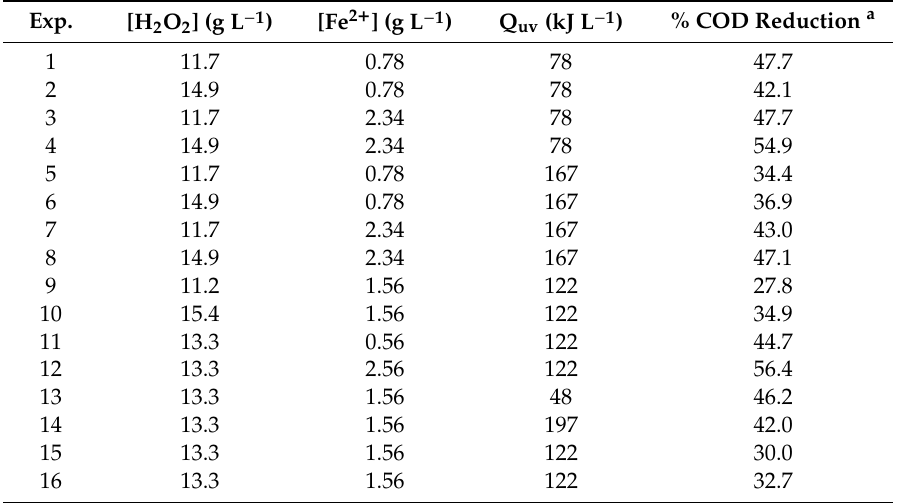
Table 5. The 3-factor central composite experimental design of solar photo-Fenton experiments for leachate pre-treated with PAC coagulant. Results of % COD reduction. Exp.